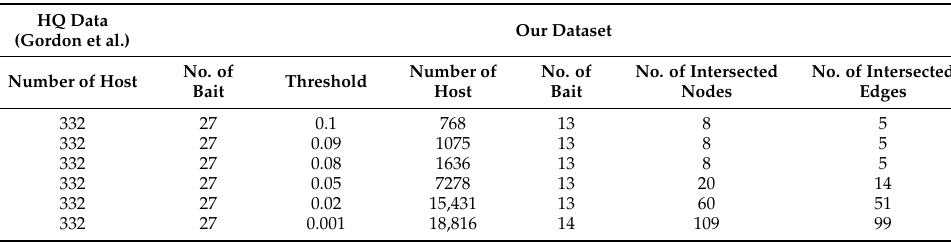
Table 7. Detailed validation of our model compared to all Human–nCov Datasets proposed by Gordon et al.